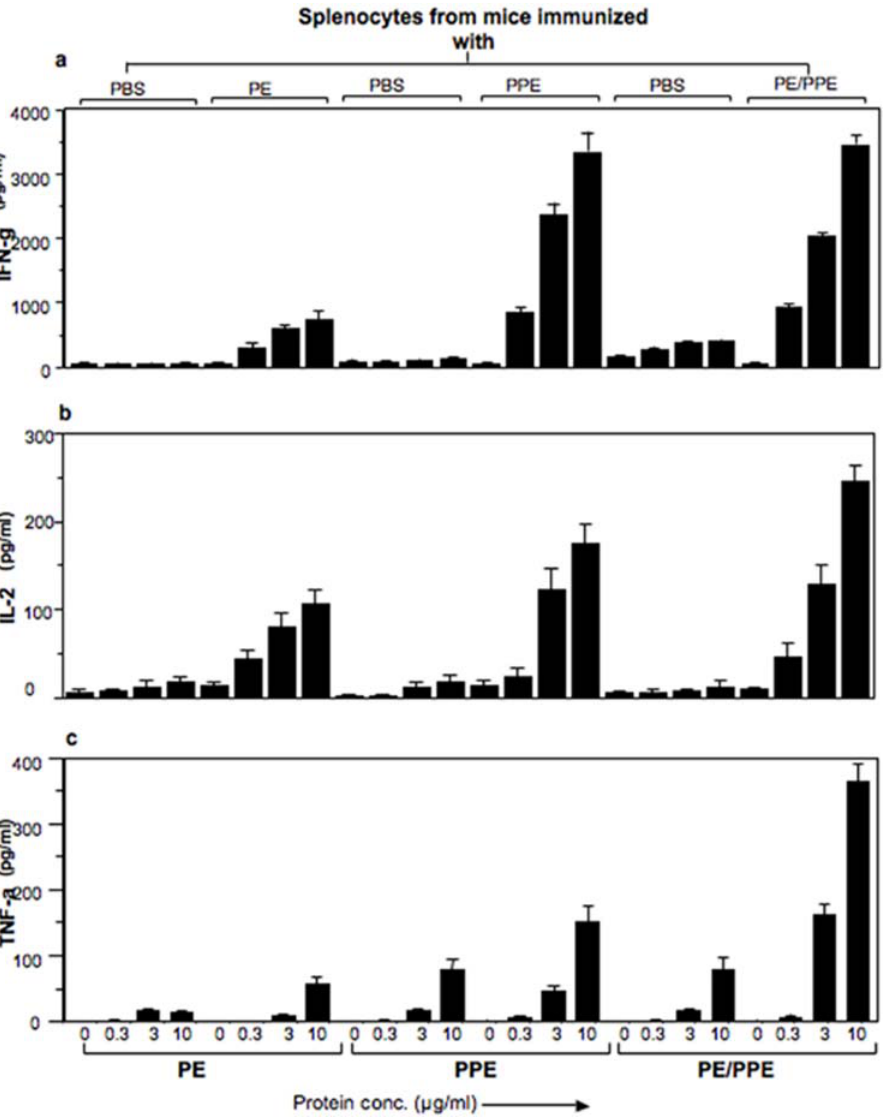
Figure 4. The PPE41 and the PE25/PPE41 protein complex induce strong IFN- c , IL-2 and TNF-alpha response. Sandwich ELISA to measure cytokines, IFN- c (a), IL-2 (b) and TNF-alpha (c) was carried out with the culture supernatants from splenocytes, isolated from mice immunized with the PE25 or PPE41 or PE25/PPE41 complex, stimulated in-vitro with the respective recombinant proteins at different concentrations (0 to 10 m g/ ml). Data shown are representative of at least three experiments. Standard deviations were measured between the triplicate